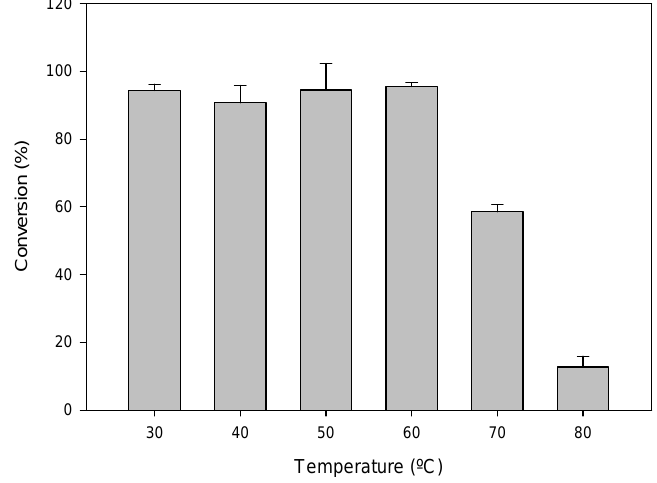
Figure 4. The immobilized four-enzyme system was incubated for 4 h at each temperature followed by a standard assay at 60 °C. The results are the mean of five experiments.